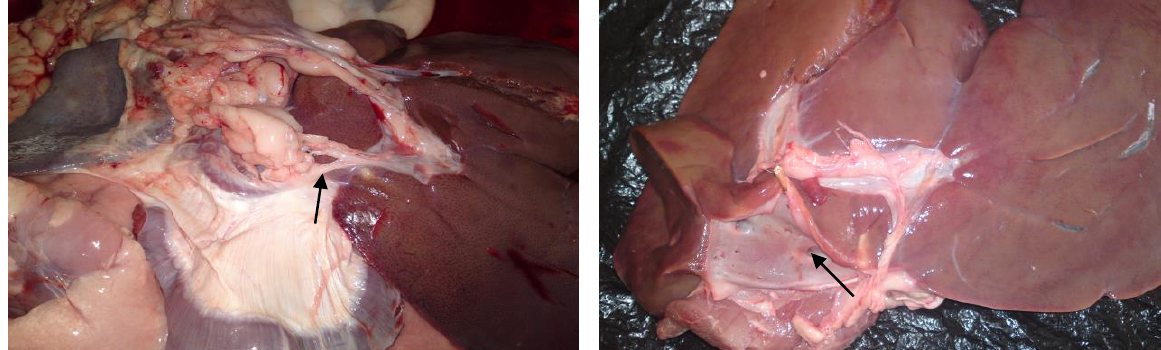
Figure, 8: Opening of the hepatic vein in sheep .